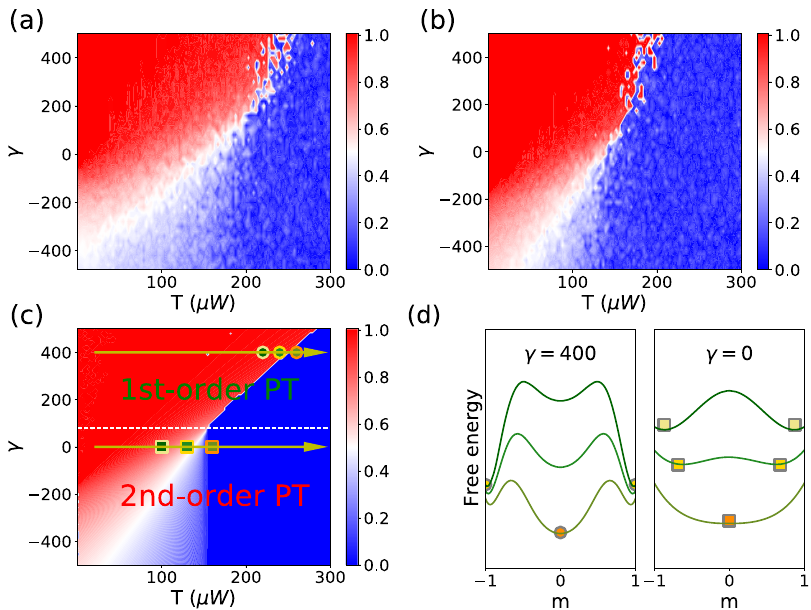
Fig. 4 Ground state phase diagrams of the nonlinear optical Ising machine. a , b are the results obtained from the full Monte-Carlo numerical simulation with the actual nonuniform and approximated uniform spin-spin interactions, respectively, and ( c ) is the result obtained from the MF theory where the system exhibits a 1st-order and a 2nd-order PT (phase transitions) separated by the white dashed line. The color bars represent the magnitude of the magnetization ∣ m ∣ . d The free energy at the points labeled in panel ( c ) [on the yellow arrows] as a function of magnetization at different temperature T and four-body coef fi cient γ . The circle and square symbols correspond to the true ground state. In b , c , we have used uniform two-body and four-body spin interactions with J ≈ 0.19 μ W , K ≈ 3.6×10 − 9 μ W .